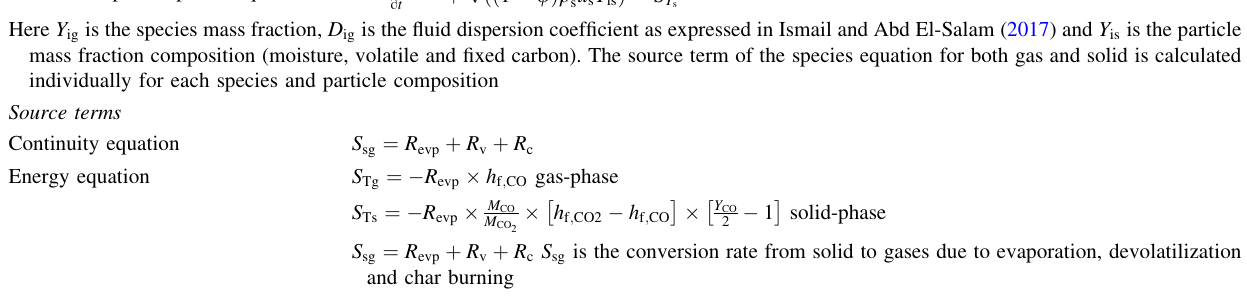
mass fraction composition (moisture, volatile and fixed carbon). The source term of the species equation for both gas and solid is calculated individually for each species and particle